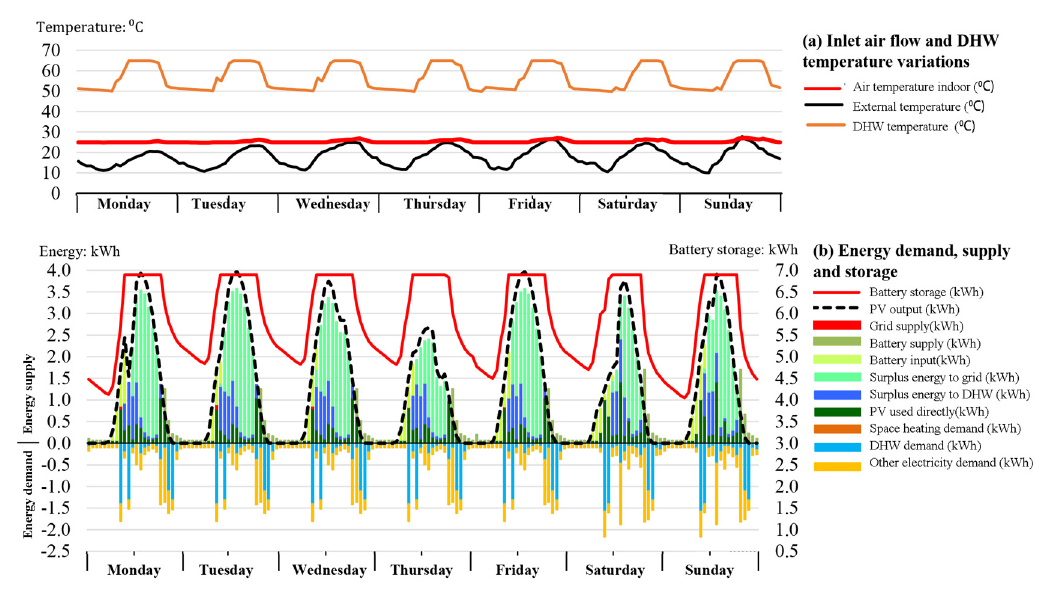
Figure 12. ( a , b ). Winter sunny week: 29 January–4 February.